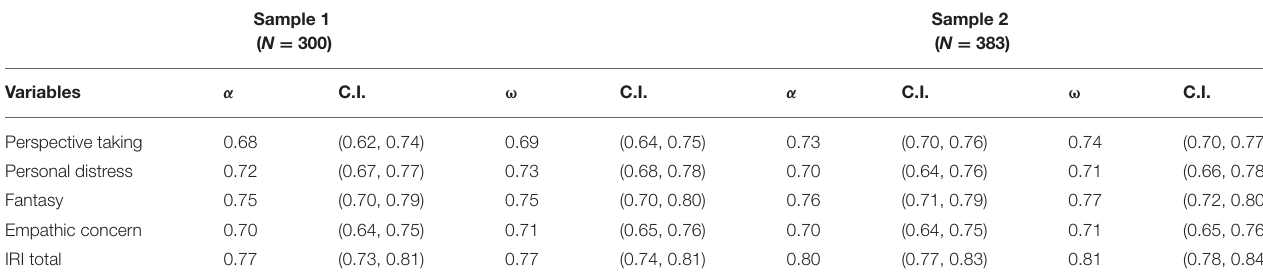
TABLE 8 | Internal reliabilities of the two